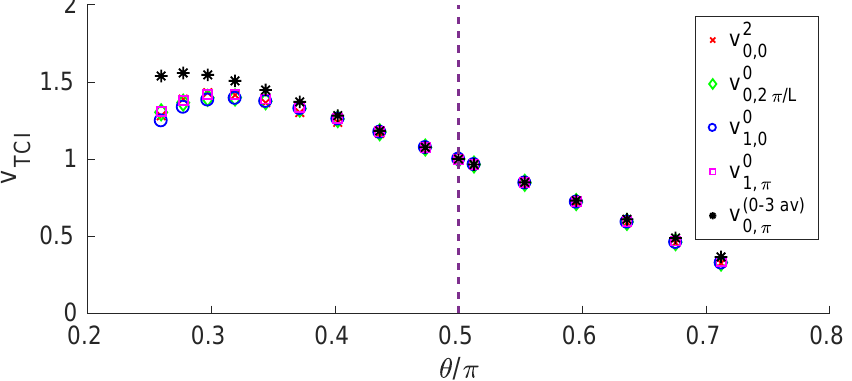
/ v = ... at vs. θ for levels with ∆ a TCI P is the average of 0, π